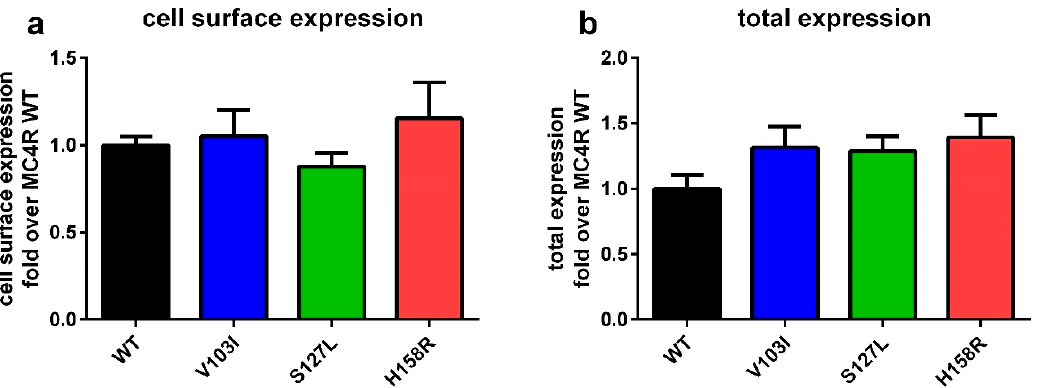
Figure 1. Cell surface expression and total expression of the melanocortin 4 receptor ( MC4R ) mutations do not significantly differ from each other. HEK293 cells were transfected with N - terminally HiBiT-tagged MC4R, a small protein tag, which is able to complement a split luciferase that cannot cross the plasma membrane. Either the cells membrane remained intact to determine receptors at the cell surface, or cells were lysed to determine the total expression of MC4R mutations. ( a ) Expression on the cell surface did not differ between the three MC4R mutations. ( b ) The total cell expression of the MC4R mutations was also not different. Values represent mean ± SEM from three to four independent experiments performed in triplicates. Statistical analysis was performed using a one-way ANOVA, followed by Dunnett’s post-hoc test.